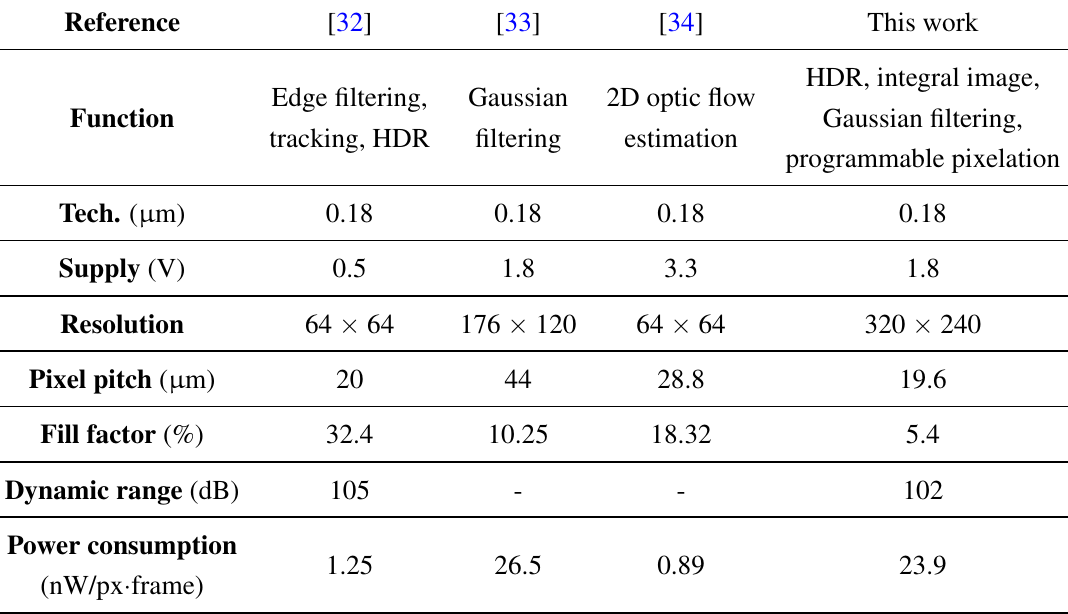
Table 2. Comparison of the proposed prototype with state-of-the-art focal-plane sensor-processor